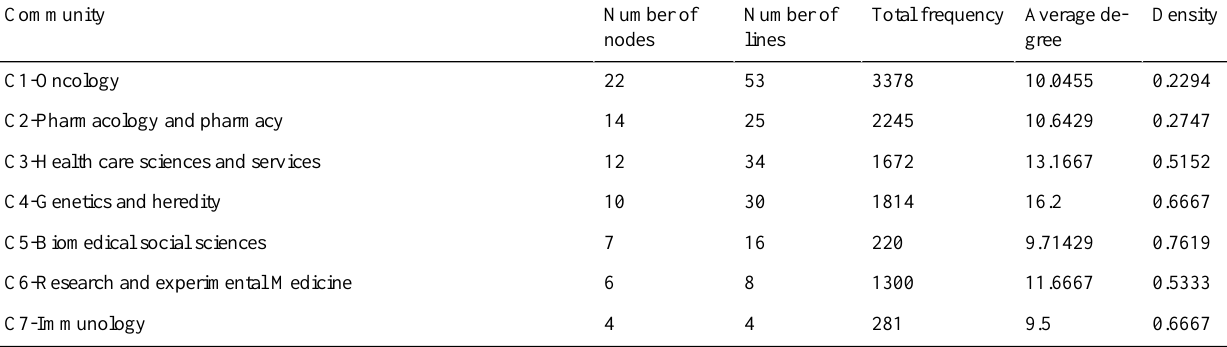
Table 6. Interdisciplinary communities of precision medicine research.